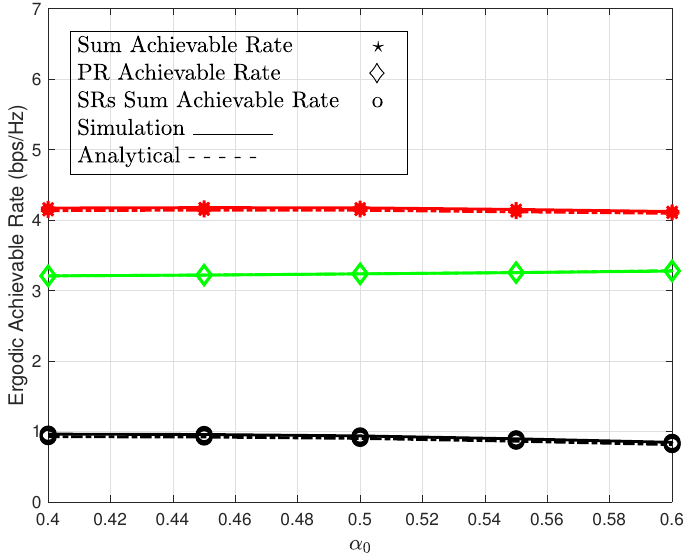
Figure 4. Ergodic achievable rate performance against different values of α 0 .